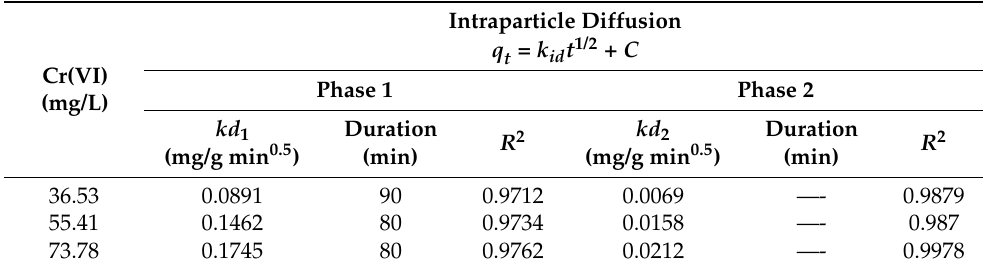
Table 2. Kinetic constants and correlation factors of intraparticle diffusion model for Cr(VI) absorption by silica-based